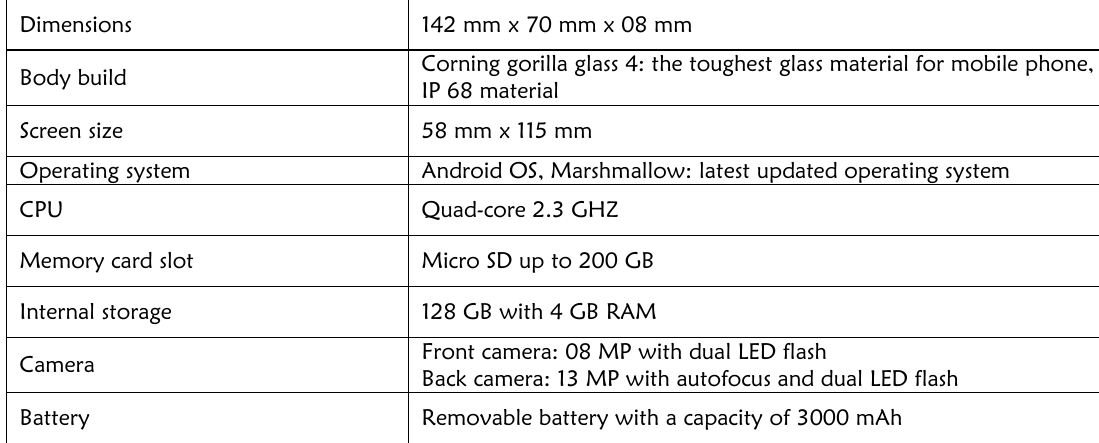
Table 6: Design specifications of the concept